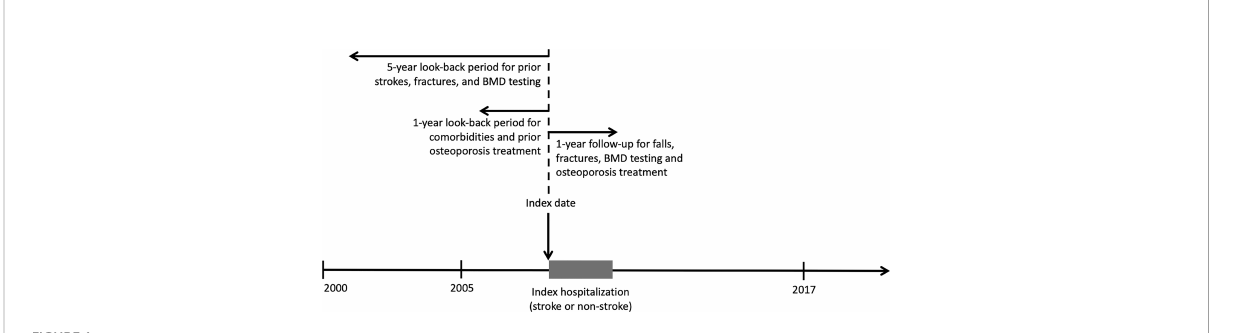
FIGURE 1 Illustration of the study design. BMD, bone mineral density; w/o, without; Tx,